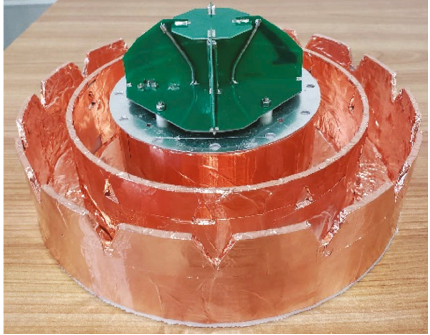
Figure 7: The antenna actually